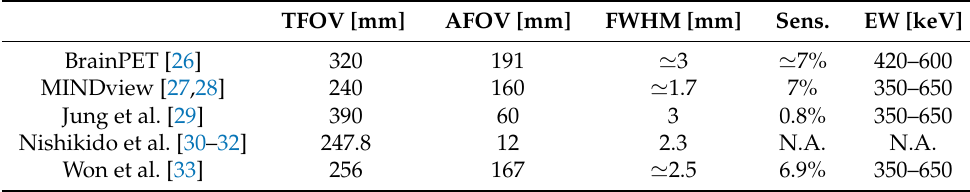
Table 2. Main specifications of brain PET/MR state of the art systems. The TFOV and AFOV are reported as well as spatial resolution, sensitivity and the EW applied.